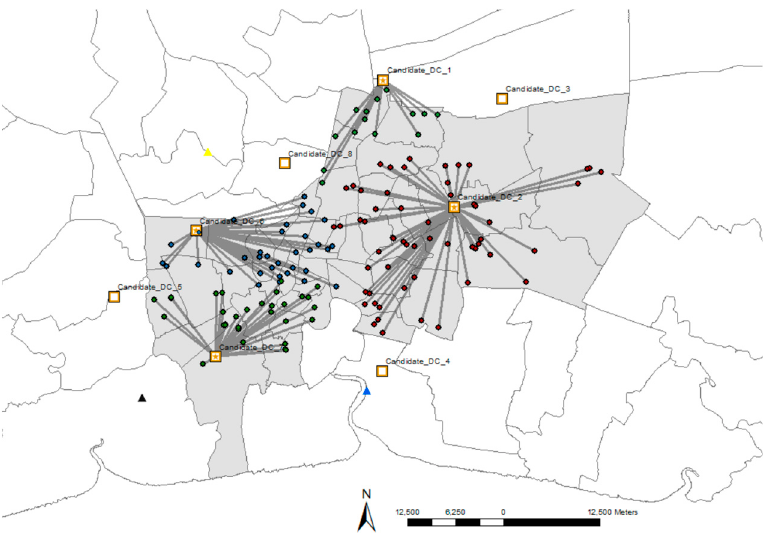
Figure 7. Examples of location–allocation problem (LAP) in ArcGIS software (scenario 5).